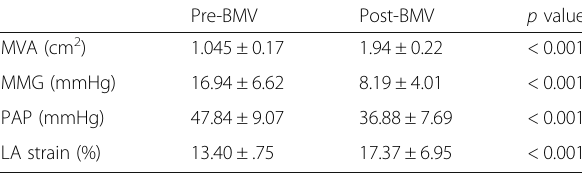
Table 1 Clinical and trans-thoracic echocardiographic findings before and after balloon mitral valvotomy